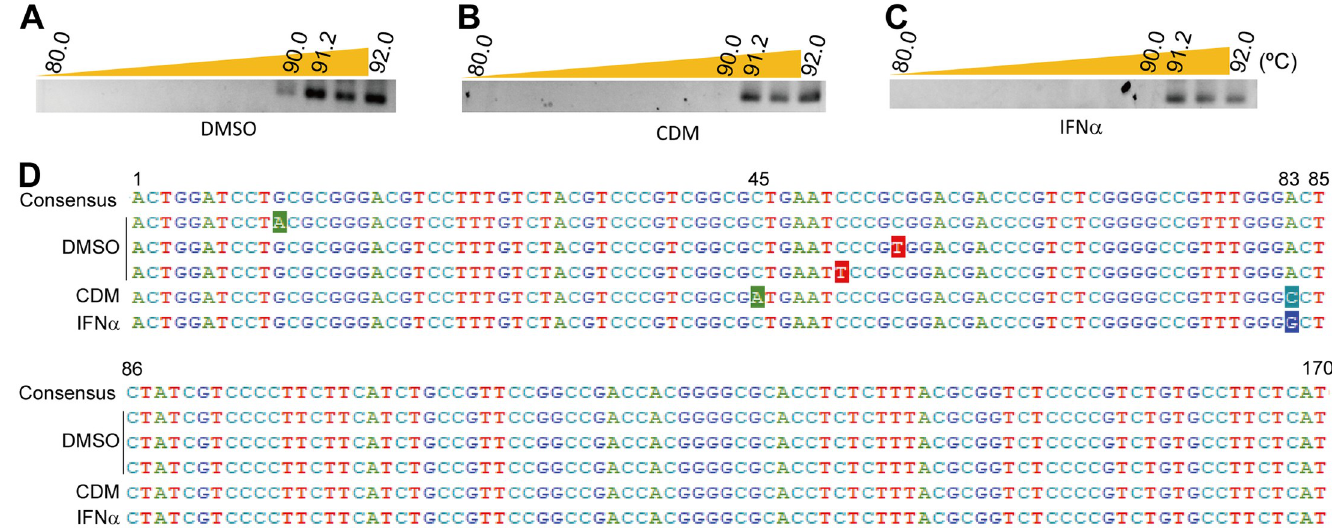
Fig 6. 3D-PCR analysis for detection of APOBEC3 activity. (A-C) 3D-PCR products (170 bp) amplified from DMSO- (A), CDM-3008- (B), and IFN α - (C) treated PXB cells at different denaturation temperatures (80–92 ˚C) were separated by 2% agarose gel electrophoresis and visualized. (D) The 3D-PCR products obtained at a denaturing temperature of 91.2 ˚C were sequenced, aligned with the consensus sequence, and numbered. Mutations are shown as inverted letters.